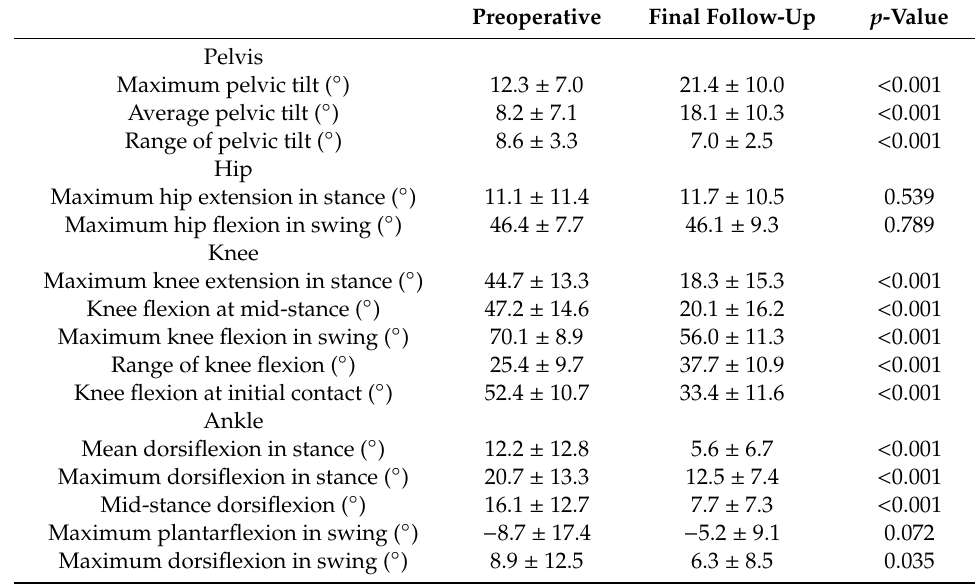
Table 3. Preoperative and final follow-up kinematic results for the whole